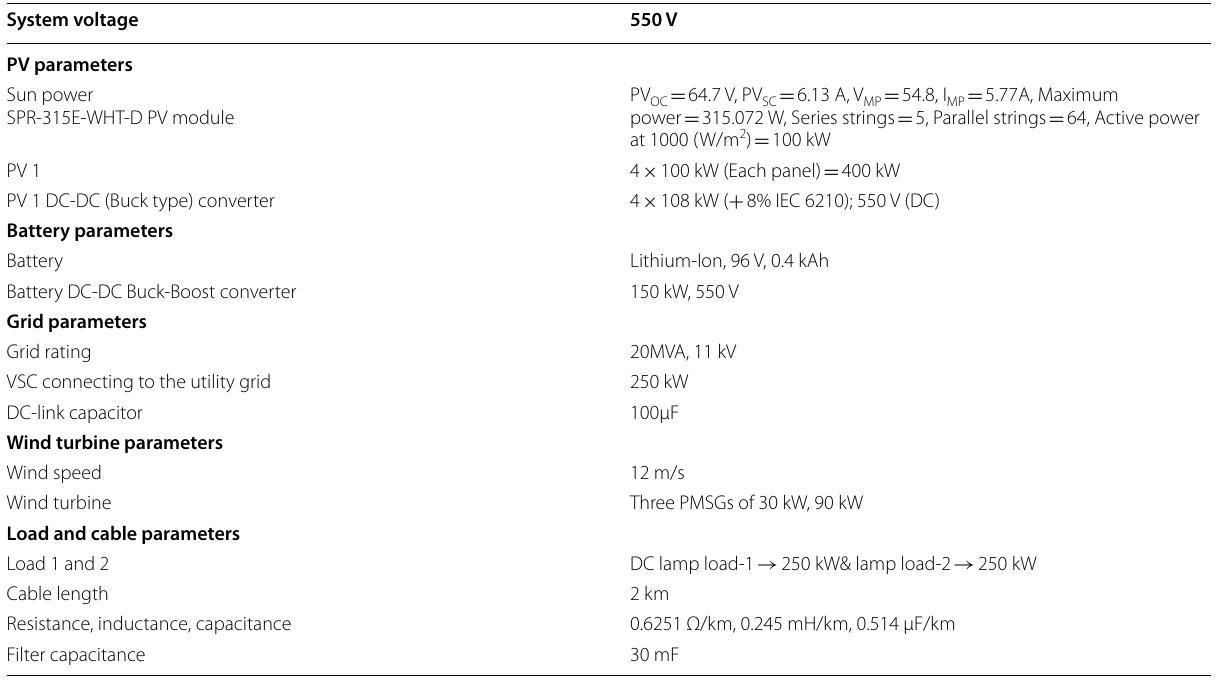
Table 1 Parameters of the proposed model System voltage 550 V